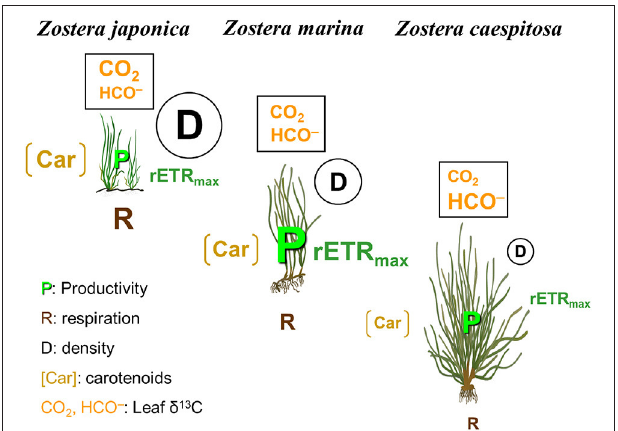
FIGURE 10 | Conceptual model showing vertical zonation patterns of three Zostera species ( Z. japonica , Z. marina , and Z. caespitosa ) meadows, where the differences in environmental factors (light irradiance, desiccation stress, wave action, temperature, and carbon source) result in physiological and morphological acclimation and meadows